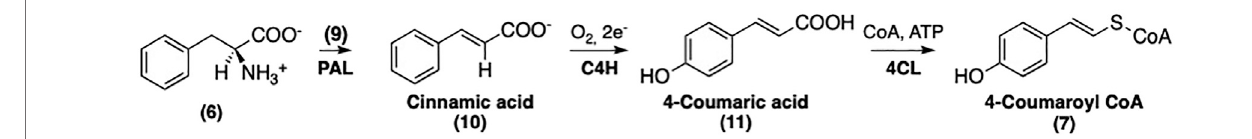
FIGURE 4 | The formation of 4-coumaroyl CoA.